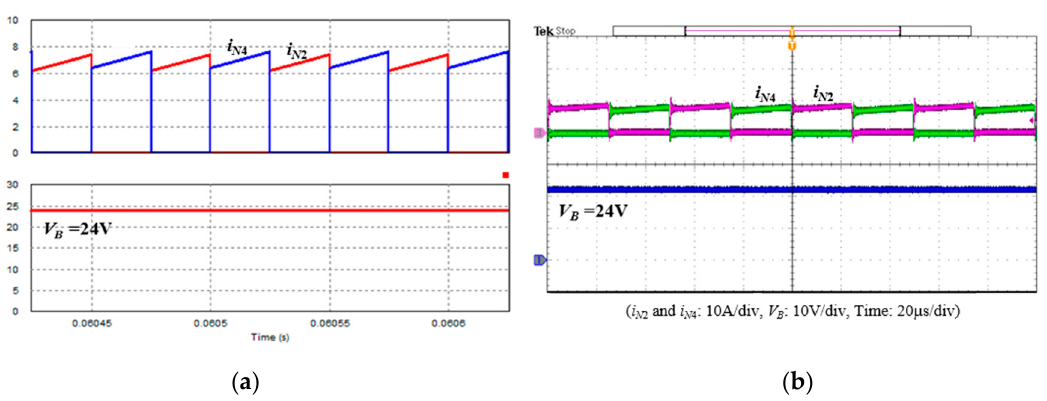
Figure 16. The waveform of the secondary-side currents of the coupled inductor and UC voltage in the battery charge mode with D c = 0.5: ( a ) simulated and ( b ) experimental.